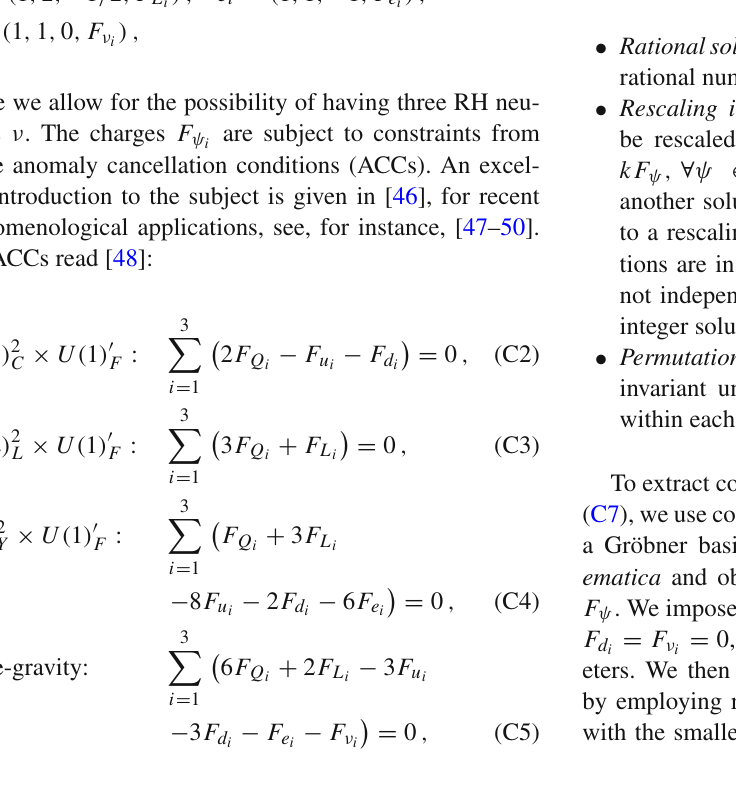
Table 6 Sample solutions of the ACCs (C2)–(C7) in a U ( 1 ) (cid:3) extension of the SM + 3 ν R . Only solutions 4, 7 require RH neutrinos. The ordering of generations is arbitrary due to permutation invariance, see text Solution